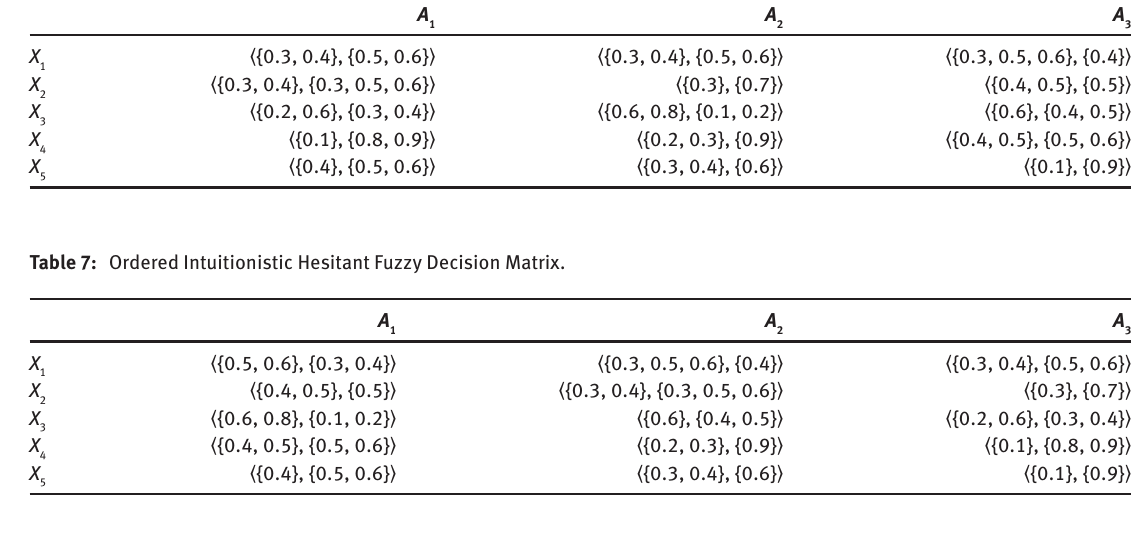
Table 6: Intuitionistic Hesitant Fuzzy Decision Matrix.